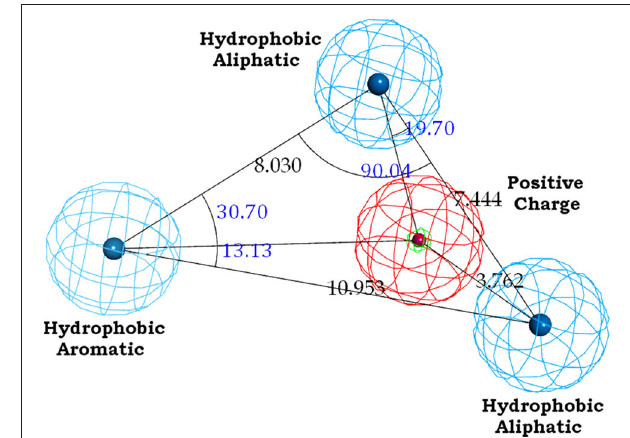
FIGURE 8 | The common feature pharmacophore for mu and kappa opioid